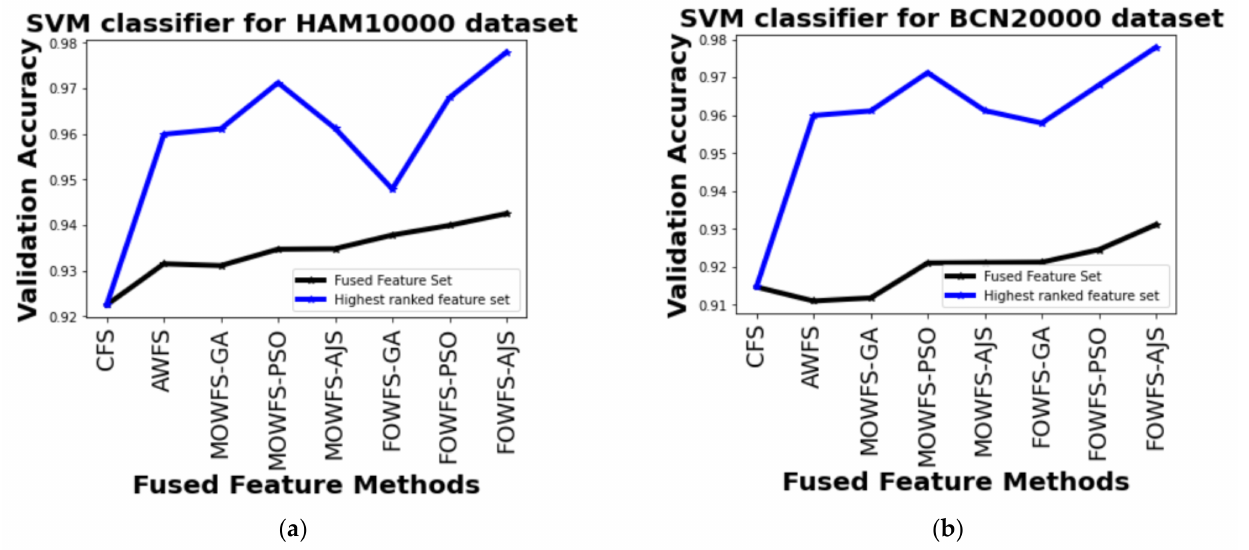
Figure 9. Comparison of validation accuracy for fused feature set and highest ranked feature set using SVM classifier for ( a ) HAM 10000 dataset and ( b ) BCN 20000